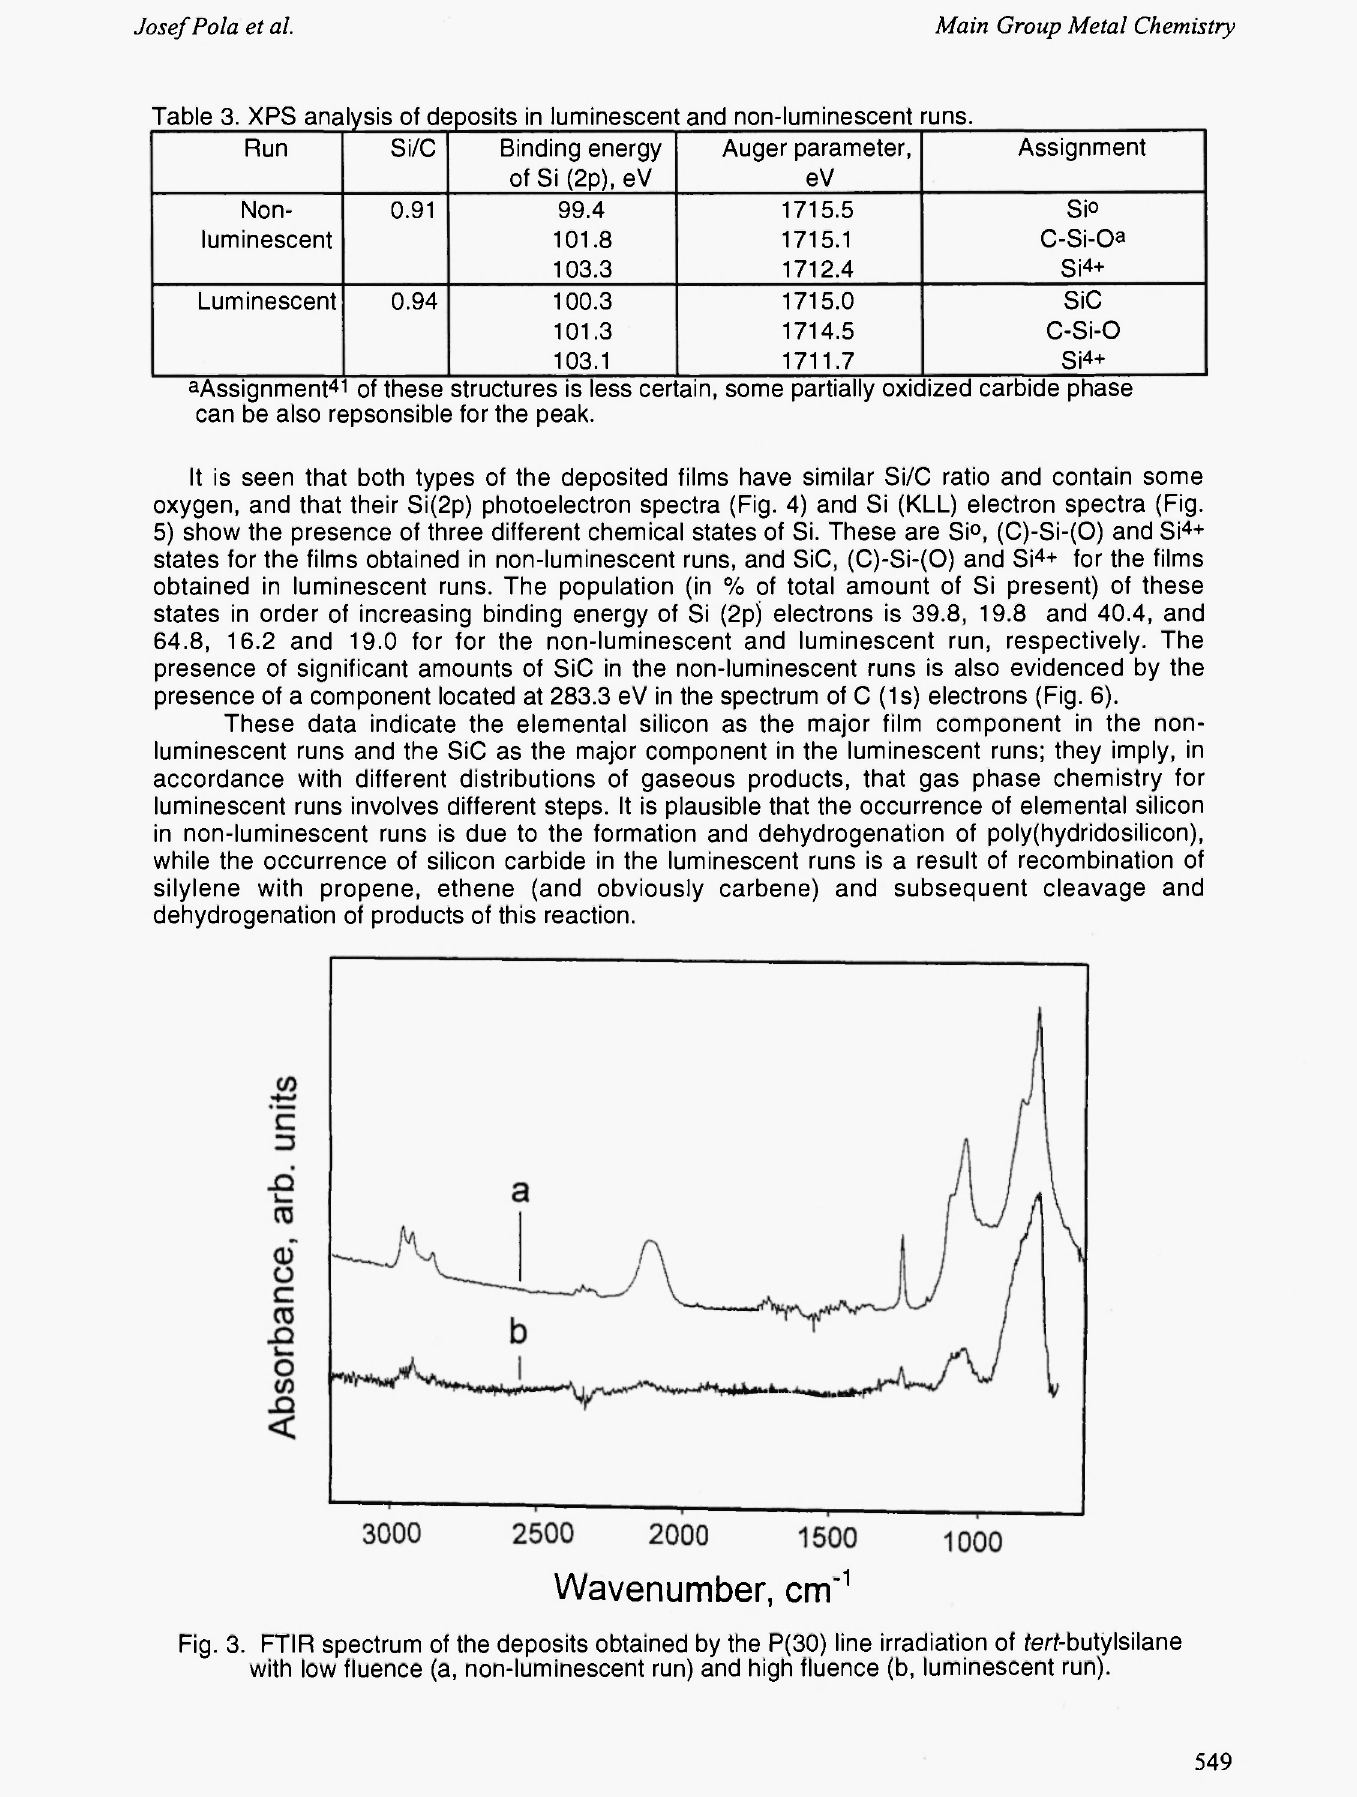
Table 3. XPS analysis of deposits in luminescent and non-luminescent runs.